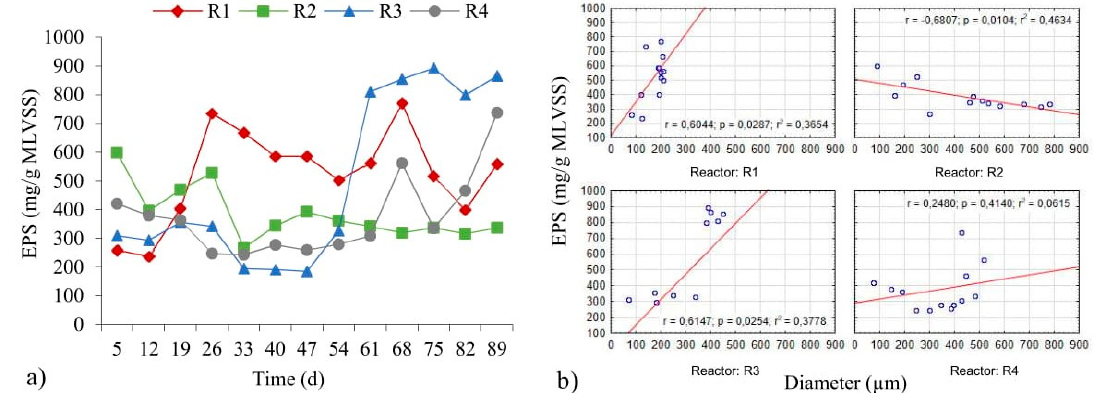
Figure 2. Variations of EPS in successive days ( a ), as well as the relationship between amount of EPS and diameters of the granules ( b ).